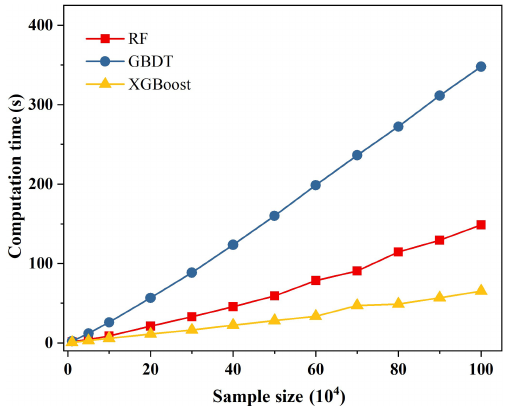
Figure 12. Comparison of computation time of three ML classifi- cation